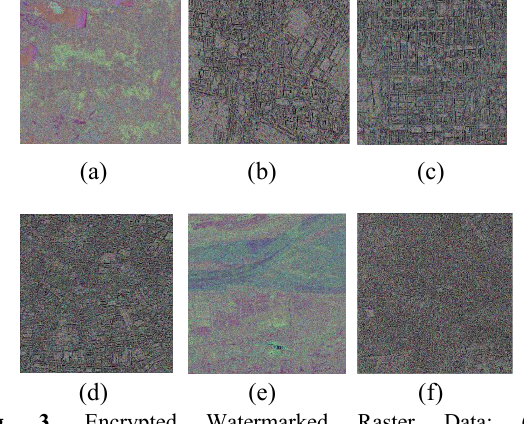
Fig. 3 . Encrypted Watermarked Raster Data: (a)